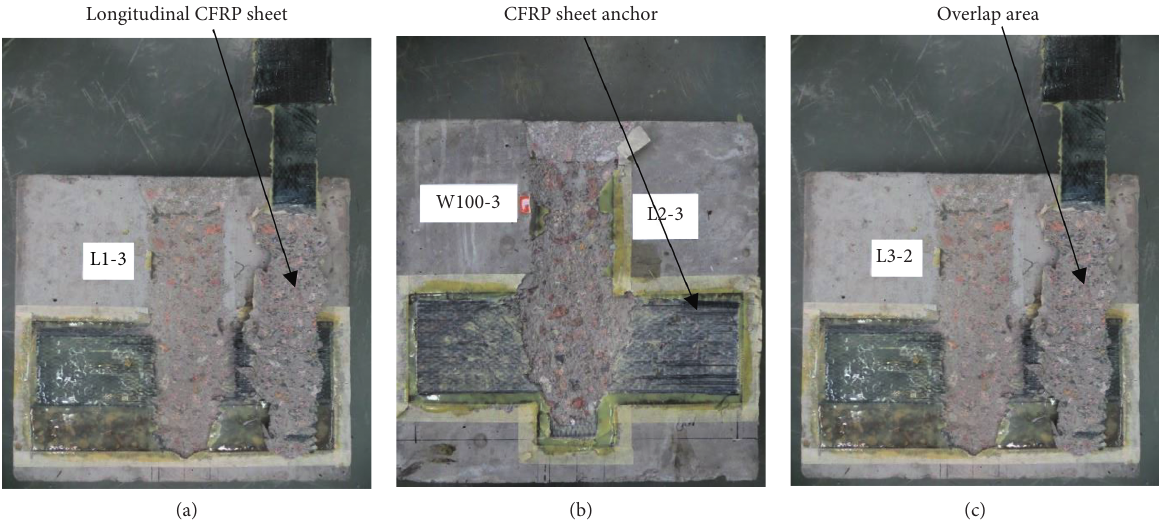
Figure 3: Failure modes of longitudinal CFRP sheet and the CFRP sheet anchor. (a) L1-3. (b) L2-3. (c)